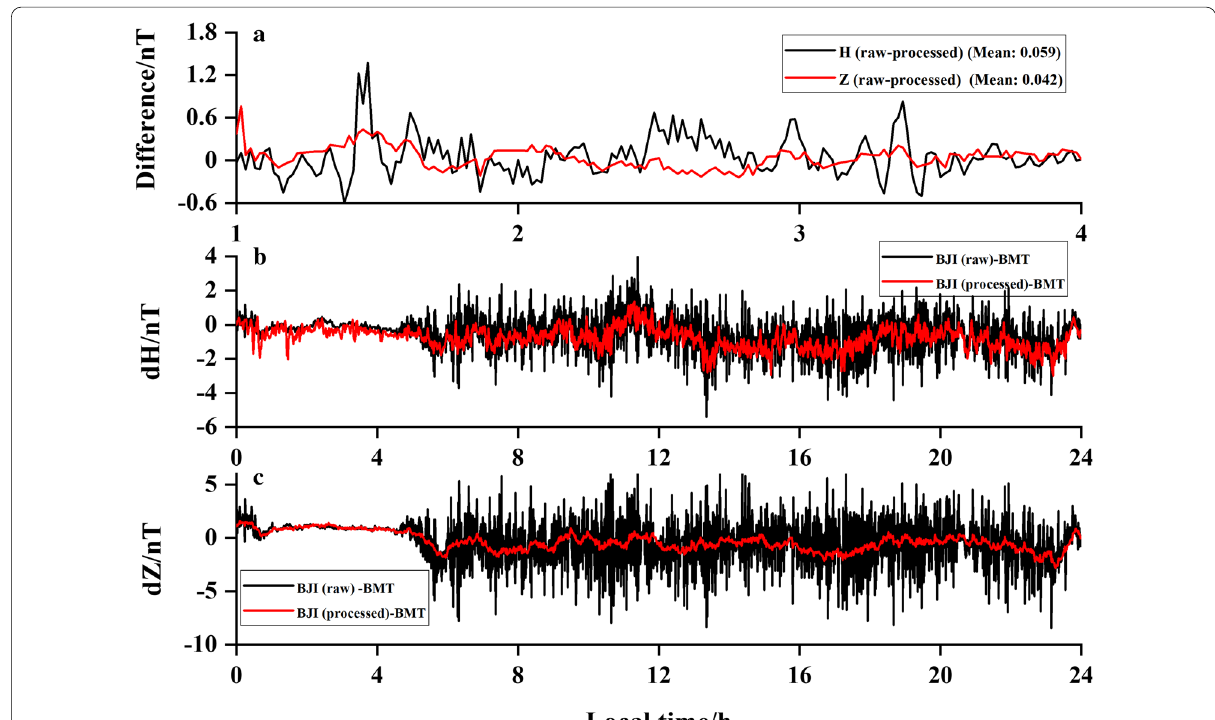
Fig. 8 Difference between the raw data and processed data by the adaptive Kalman filter at BJI ( a ). Difference between BMT and BJI before and after processing for horizontal component ( b ) and vertical component ( c